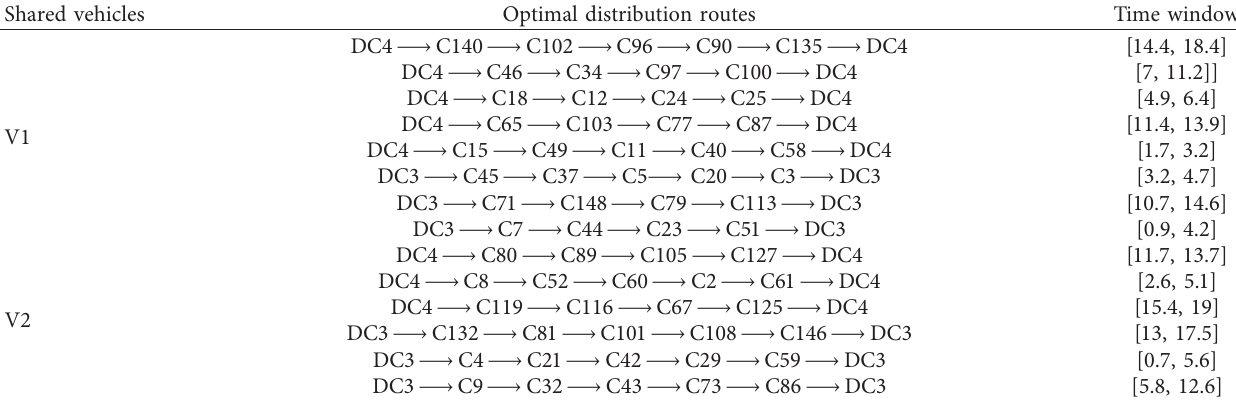
Table 6: Optimal distribution routes and shared